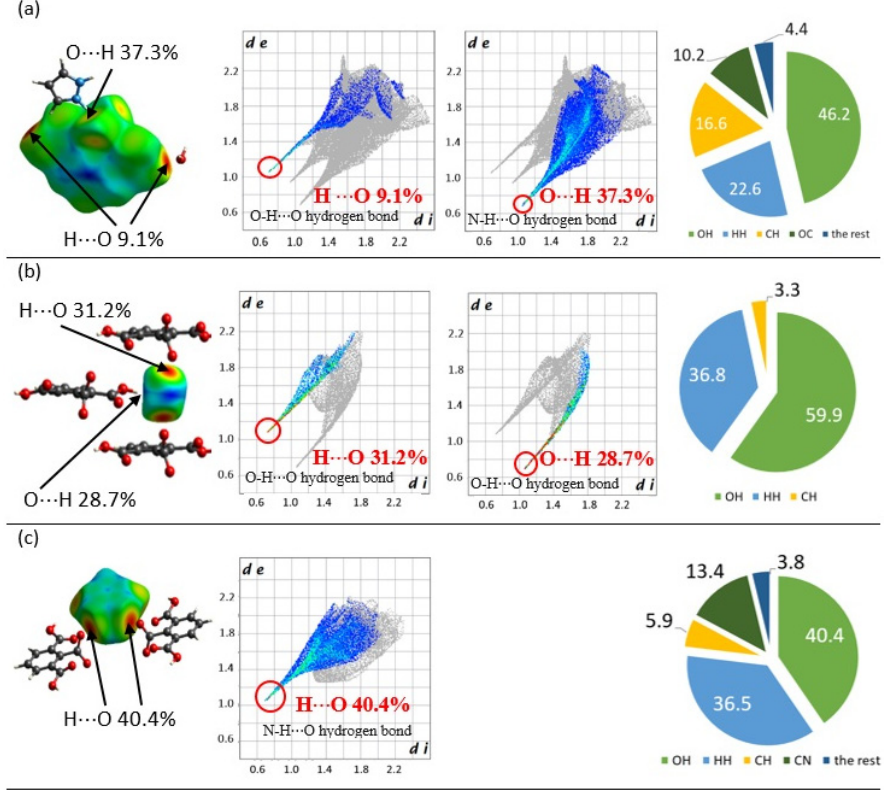
Figure 5. On the left, the Hirshfeld surfaces for the hemimellitate ion ( a ), the water molecule ( b ), and the pyrazolium ion ( c ) mapped with d i ; mapping range: red (short distance) through green to blue (long-distance). In the middle, fingerprint plots ( d e versus d i ) for these features involving specific pairs of atoms; on the right, histograms showing the percentage of different types of interactions taking place in the studied salt.